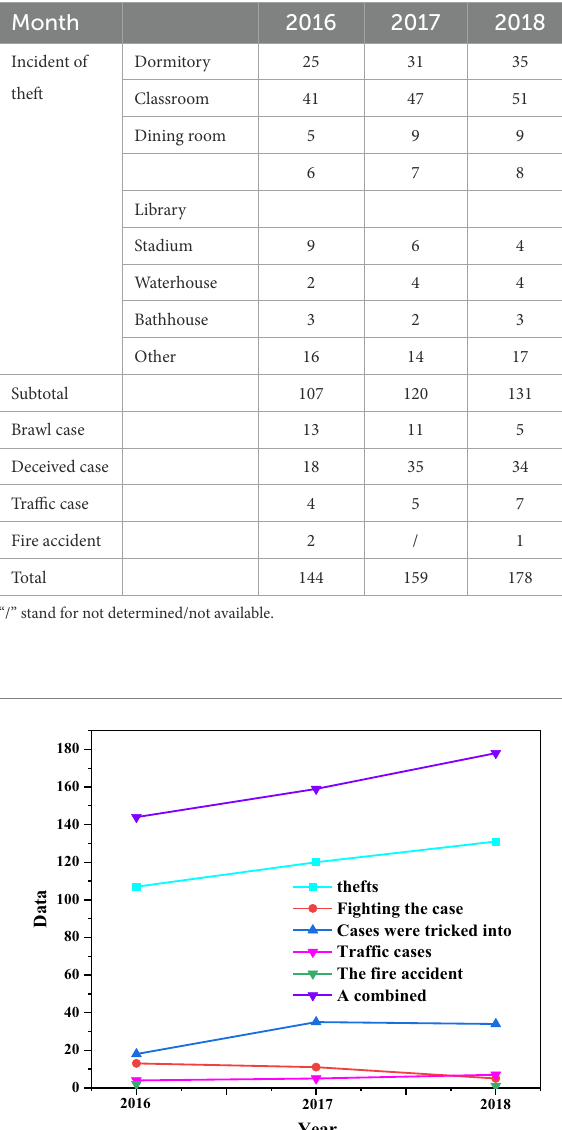
TABLE 4 Statistical summary of security incidents in a university from 2016 to 2018.